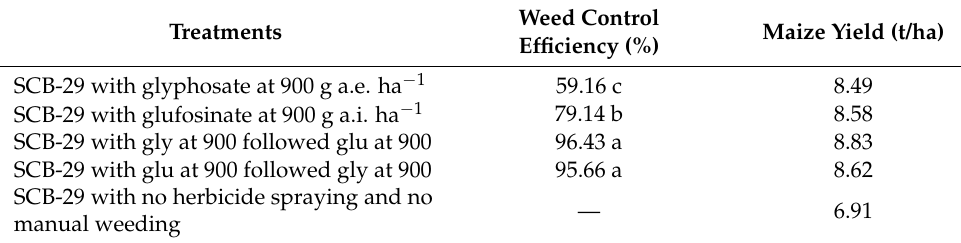
Table 2. Effect of different treatments on weed control efficiency and maize yield. Treatments